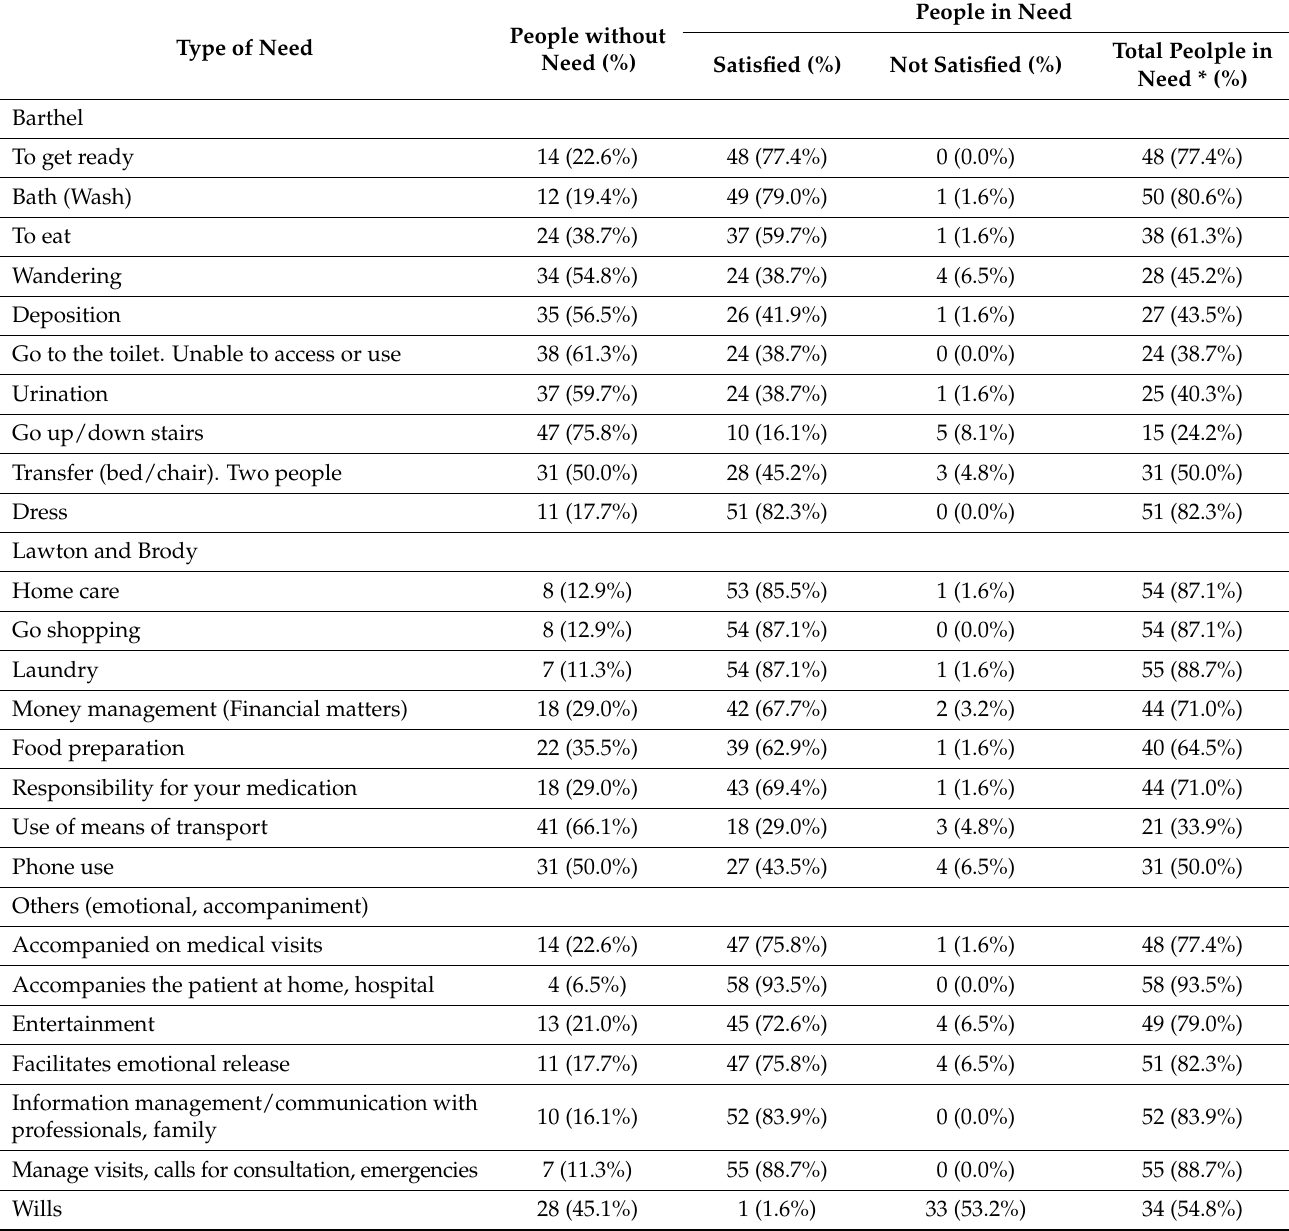
Table 4. Type of needs in the final